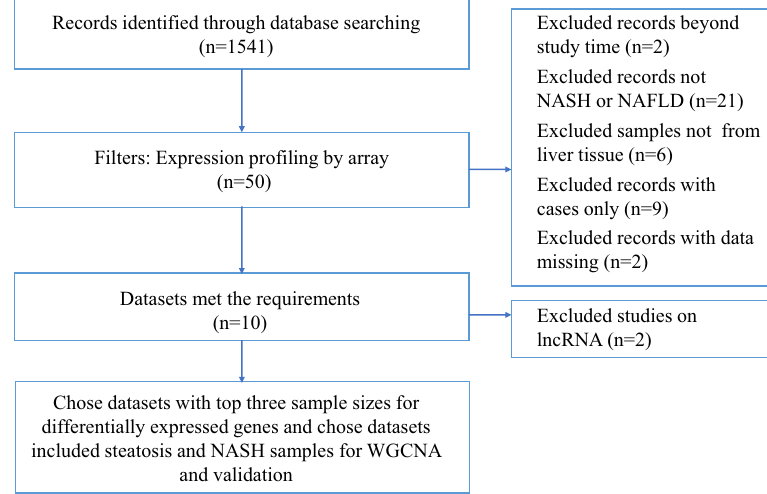
Figure A1: fl ow chart of screening datasets.